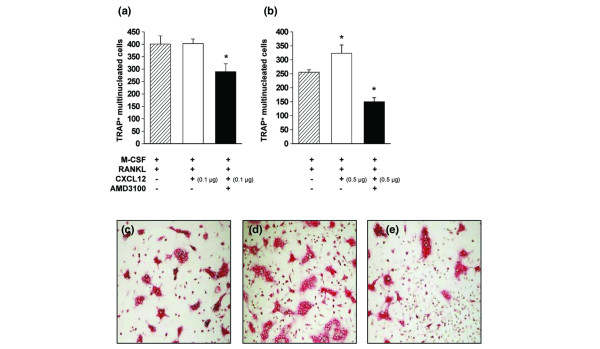
CXCL12 stimulates and AMD3100 inhibits osteoclast differentiation. Splenocytes of three collagen type II/complete Freund's adjuvant-immunized mice were isolated and pooled. (a,b) Splenocytes were cultured for 6 days in the cups of a chamberslide, in the presence of the indicated stimuli (macrophage colony-stimulating factor (M-CSF), 20 ng/ml; receptor activator of NF-κB ligand (RANKL), 100 ng/ml; CXCL12, 0.1 μg/ml in (a), 0.5 μg/ml in (b); AMD3100, 25 μg/ml). After stimulation, cells were fixed and stained for the presence of tartrate-resistant acid phosphatase (TRAP). TRAP+ multinucleated (three or more nuclei) cells were counted within each cup. Bars represent averages ± standard error of the mean for four cultures. The asterisk represents p < 0.05 compared with the hatched bar (Mann-Whitney U-test). Representative pictures for TRAP-stained cultures stimulated with (c) M-CSF and RANKL alone and with added (d) CXCL12 (0.5 μg/ml) or (e) CXCL12 and AMD3100.